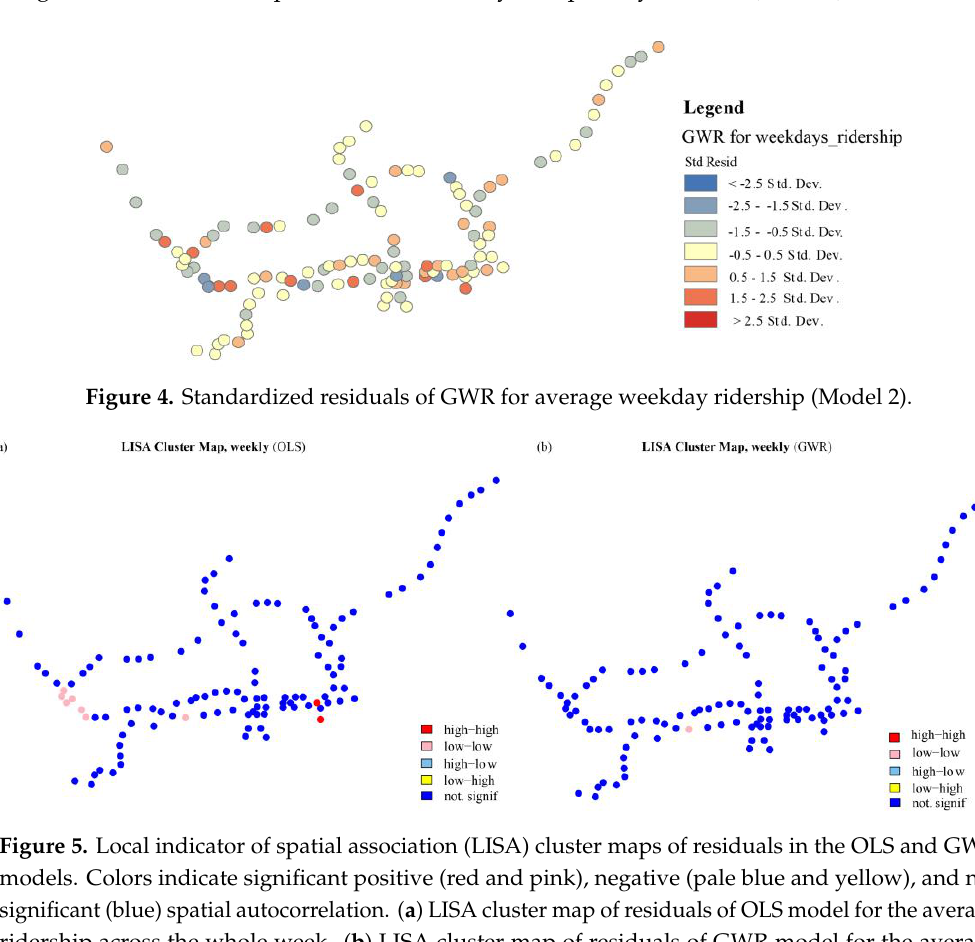
Figure 4. Standardized residuals of GWR for average weekday ridership (Model 2). Table 6. Global Mora n’s I residuals test of the models for the average ridership across the whole week.